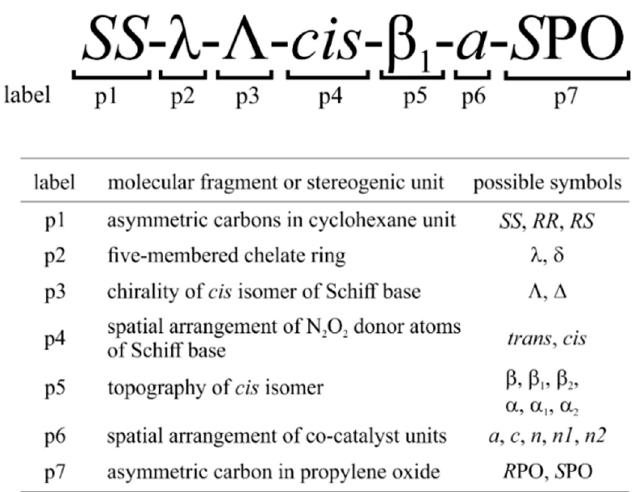
Figure 5. Summary of factors causing stereoisomerism in the investigated Co(III)-salcy CO 2 /epoxide catalytic systems along with the adopted labelling convention.